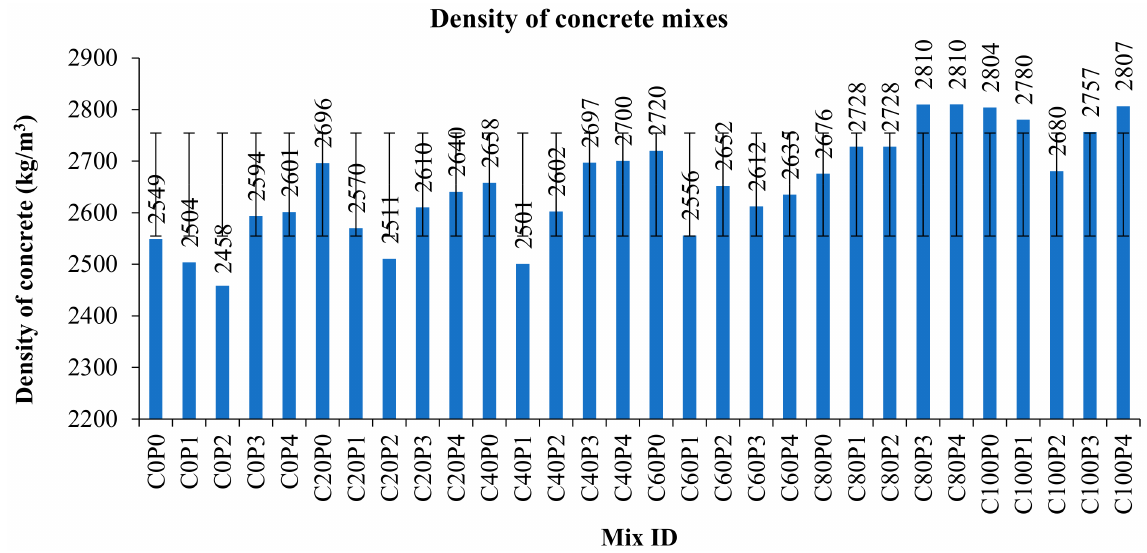
Figure 7. Density of various concrete